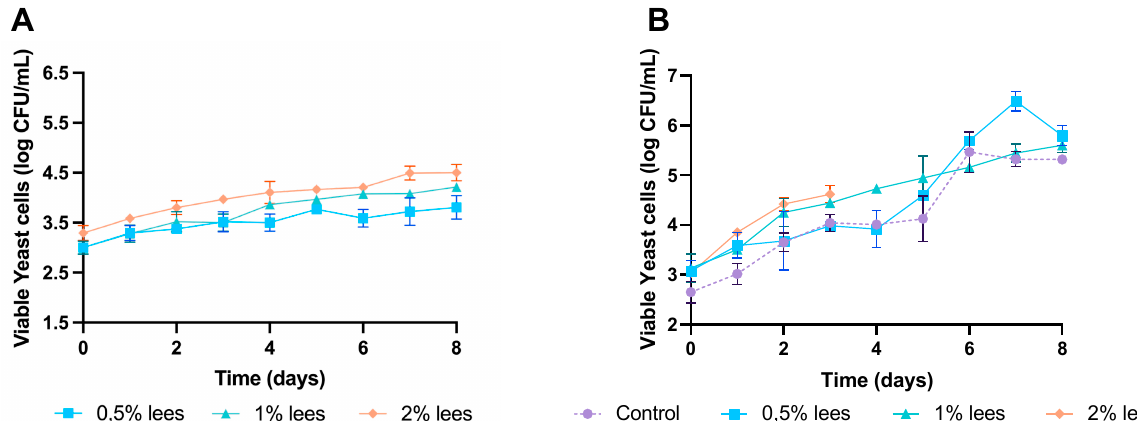
Figure 2. Growth kinetics of yeasts during sourdough fermentations: ( A ) wheat sourdoughs; ( B ) rye sourdoughs.